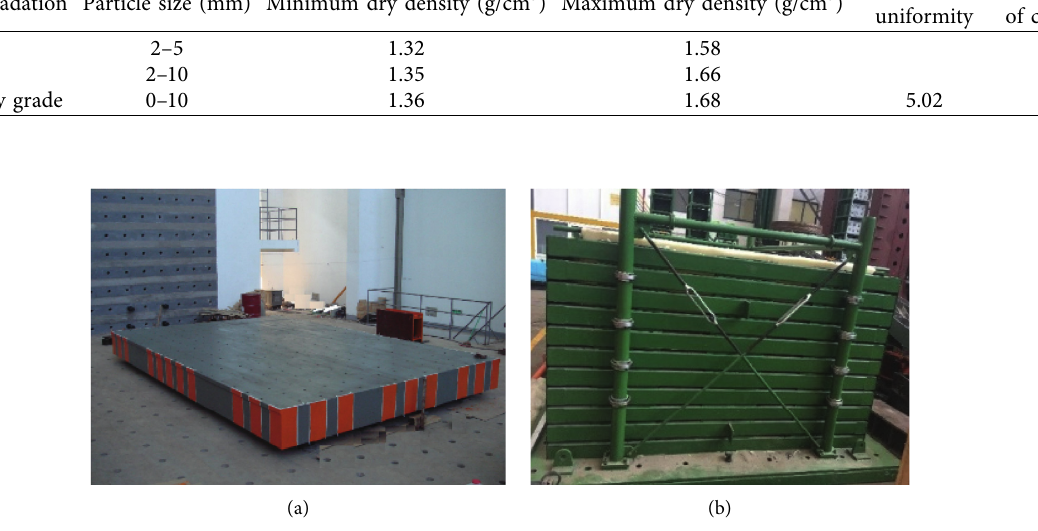
Figure 3: Shaking table and layered shear deformation model container. (a) Specimen-mounting table (4 × 6 m). (b) Model container (2 (length) × 2 (width) × 1.3 (height) (m) × 0.1 (wall